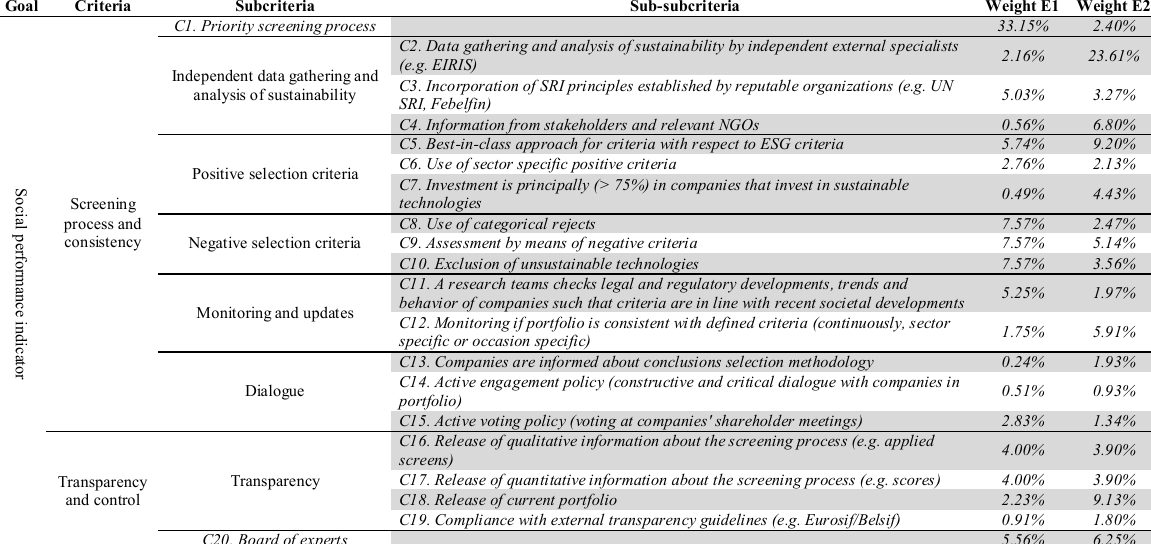
Hierarchy of criteria and weights from two independent experts Goal Criteria Subcriteria